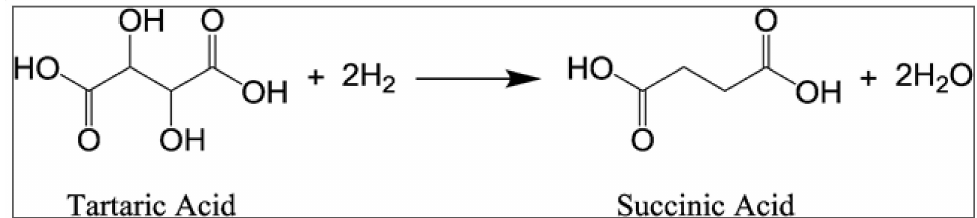
Figure 4. Direct conversion of tartaric acid in succinic